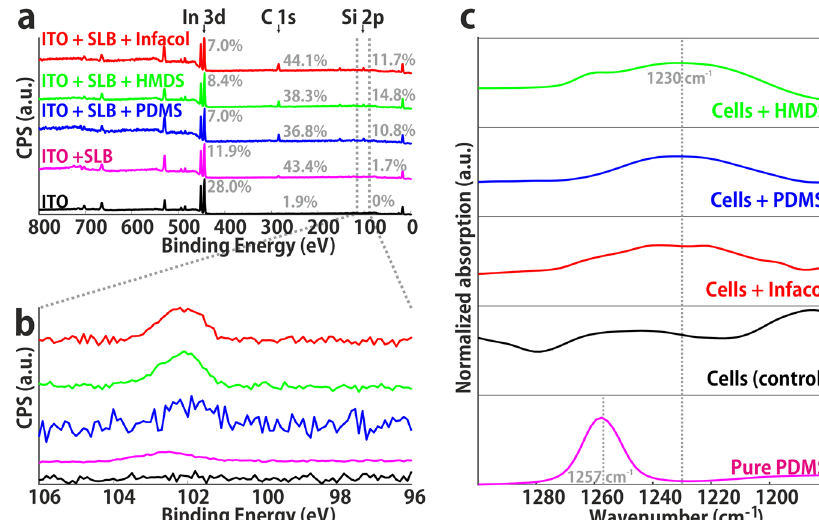
Fig. 2 Spectroscopic analysis by XPS and IR of biological membranes in the form of SLBs and biological cells. a XPS wide scan showing all atomic species present; carbon content (285 eV) increases after SLB formation and again after silicone introduction. The relative contribution of In 3d (444 eV) decreases after incubation steps. b XPS narrow scan in the Si 2p region, showing increase after silicone introduction. The presence of a trace amount of Si 2p in DOPC supported lipid bilayers (magenta) indicates a minor impurity of the chemicals. c Si-C region in IR spectra obtained from pure PDMS (pink) and cells incubated with various organosilicon compounds (green, HMDS; blue, PDMS; red, Infacol; black, negative control). Incubated cells show a shift in a peak (~1250 cm − 1 → ~1230 cm − 1 ) compared to negative control